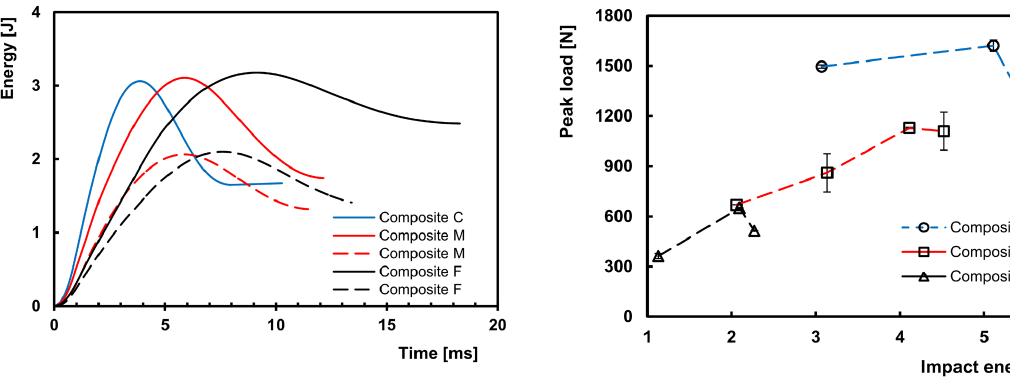
Figure 11. Peak load versus impact